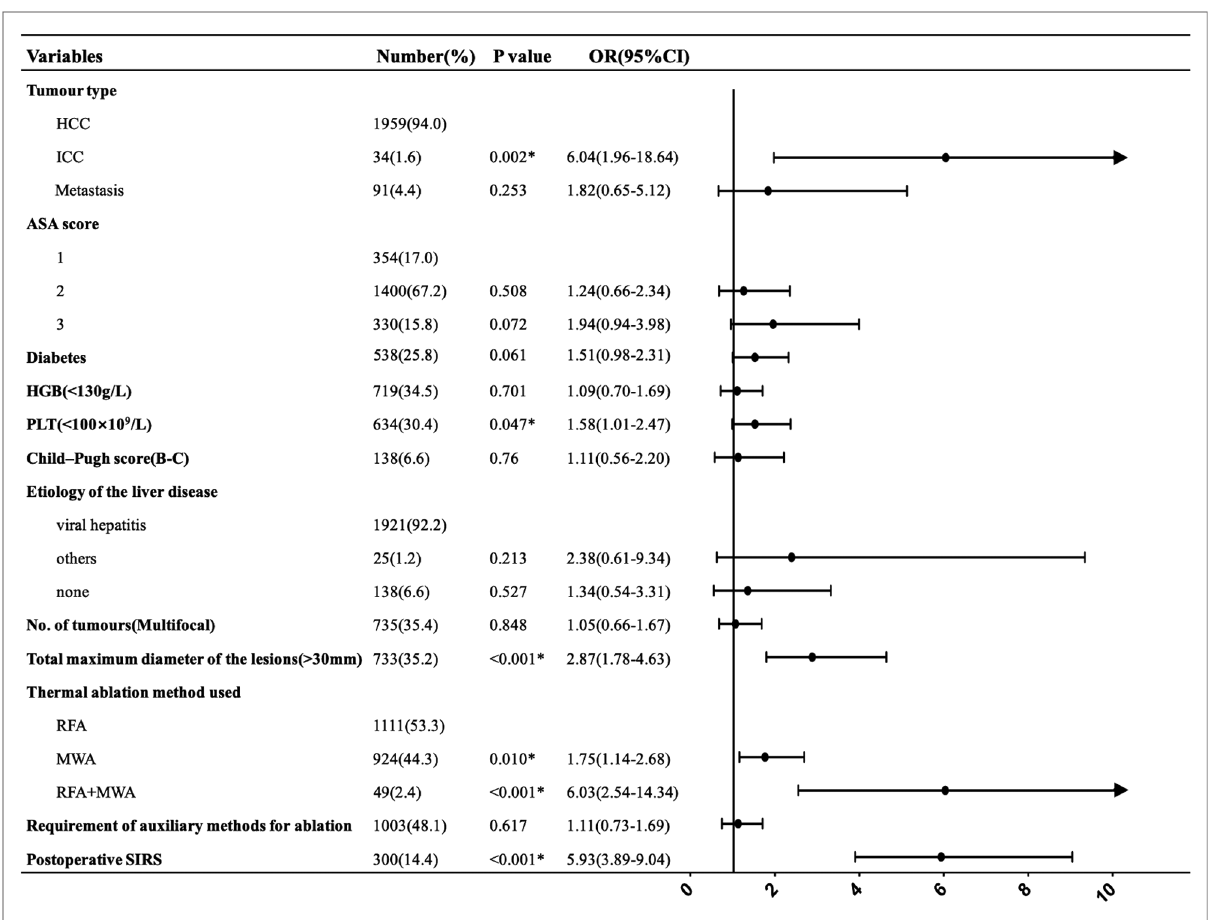
FIGURE 2 Multivariate logistic regression analyses of risk factors for major complications. *Statistically signi fi